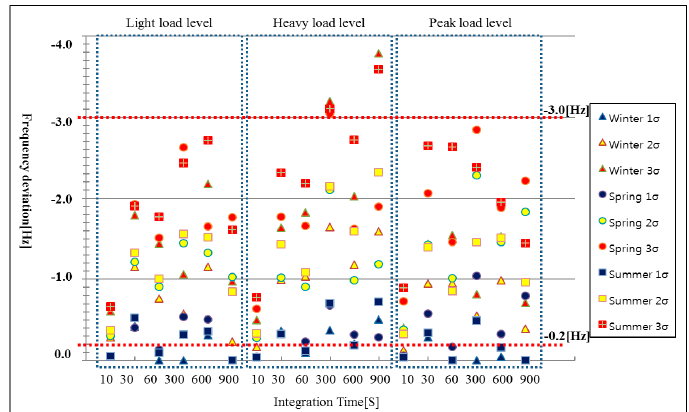
Figure 12. Frequency deviation distribution chart of P company (single model).